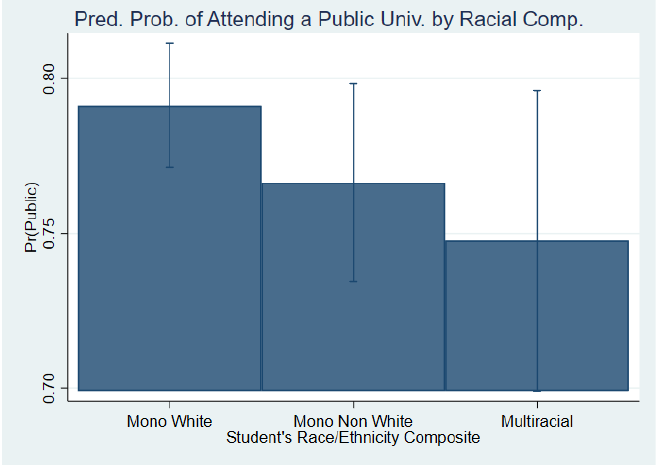
Figure 3. Pred. Prob. of Public v Private Choice by Racial Comp. using ELS data.